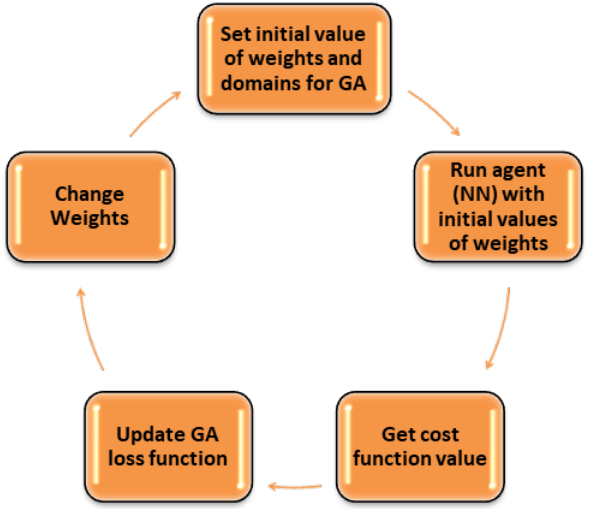
Figure 1. Loop of the GA